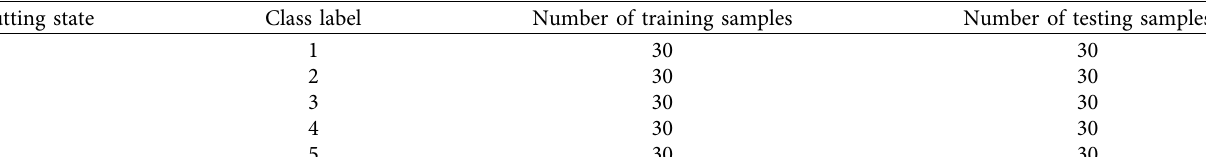
Figure 11: The sound signals of five cutting states. Table 3: The detailed arrangements of the experimental datasets for classification.